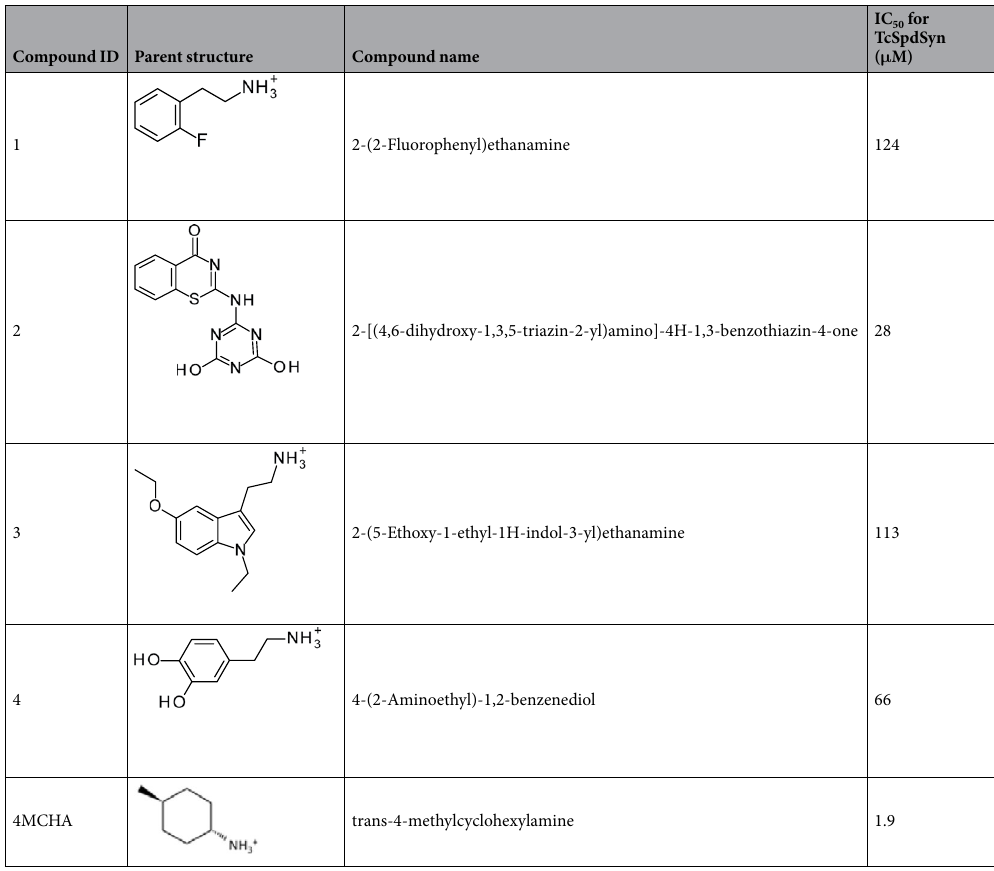
Table 1. The parent structures of compounds 1–4 and their IC 50 values. These IC50 values were determined from fitting curve in Supplementary Figure 3. Compound name is taken from the following Web site: http://